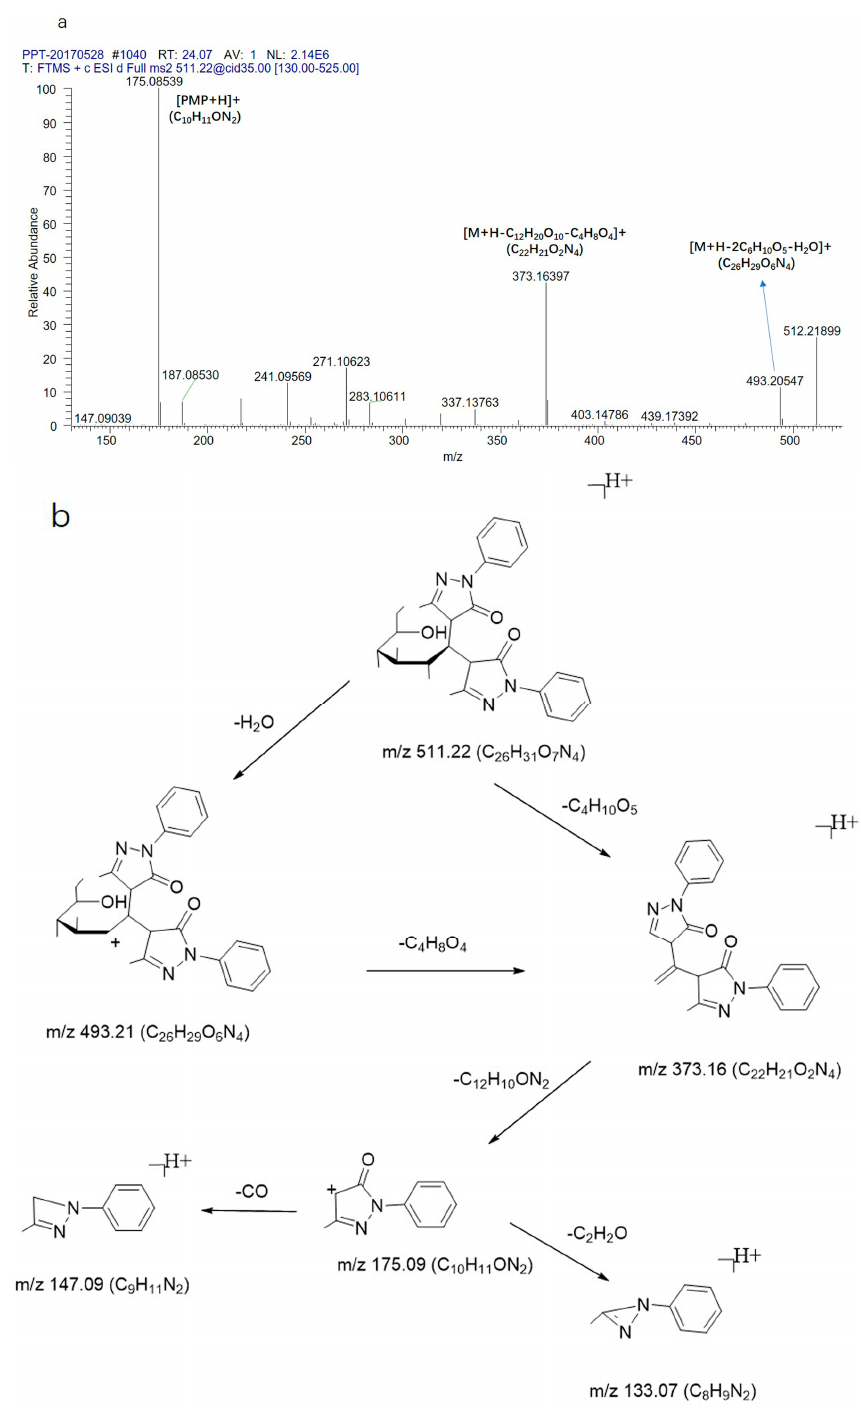
Figure 8. The ( a ) CID MS n spectrum and ( b ) fragmentation pathway of the standard of glucose.